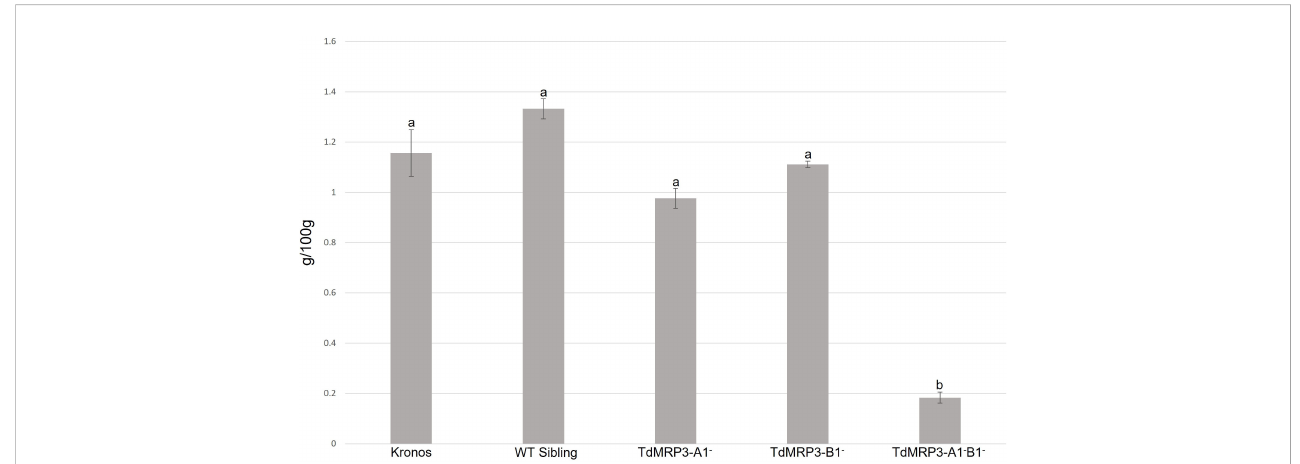
FIGURE 2 Phytic acid content in lpa mutants, WT sibling lines and cv. Kronos. Mean values of three biological replicates, error bars indicate standard error. Values followed by different letters differ signifcantly from one another (one-way ANOVA, Tukey HSD test,